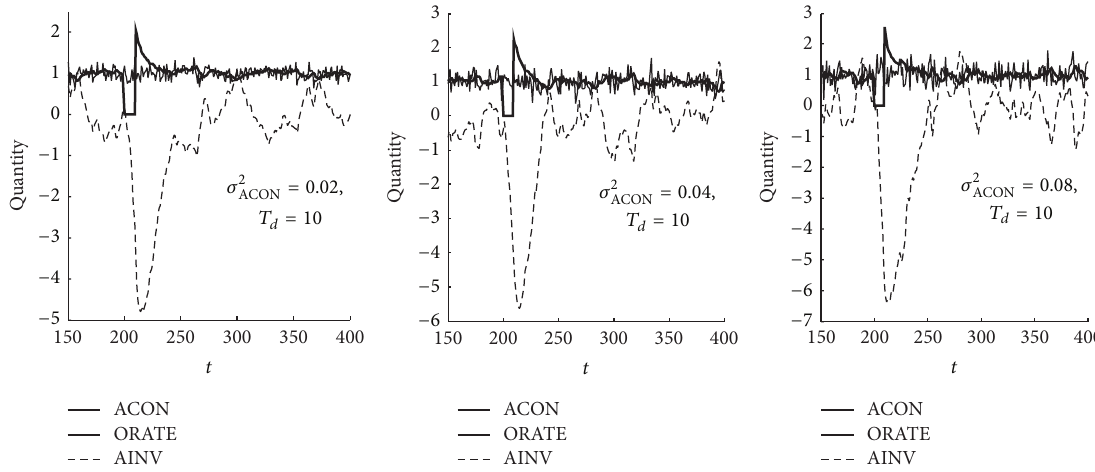
Figure 7: The change situations of ORATE and AINV for different values of 𝜎 2 ACON under random demand.